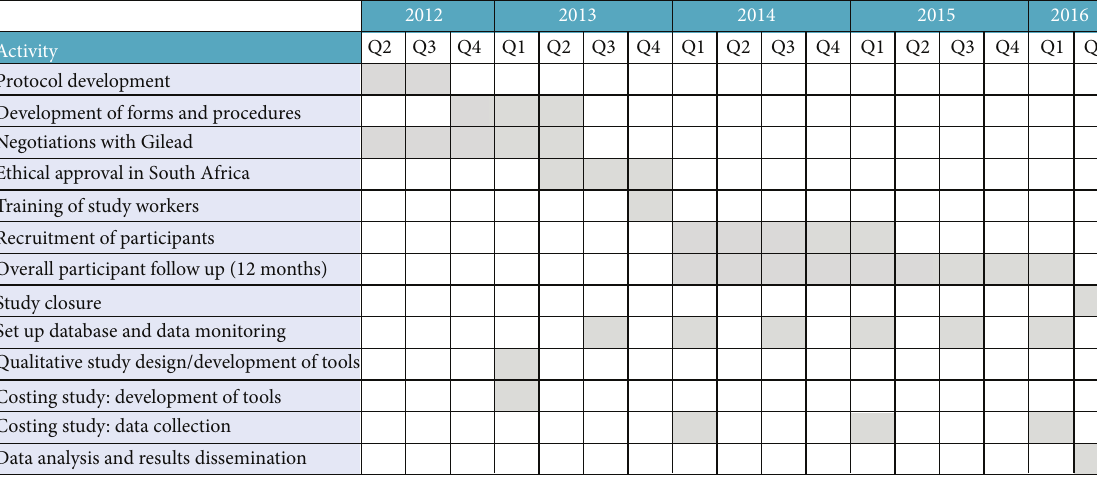
Figure 3: Project timeline detailing related